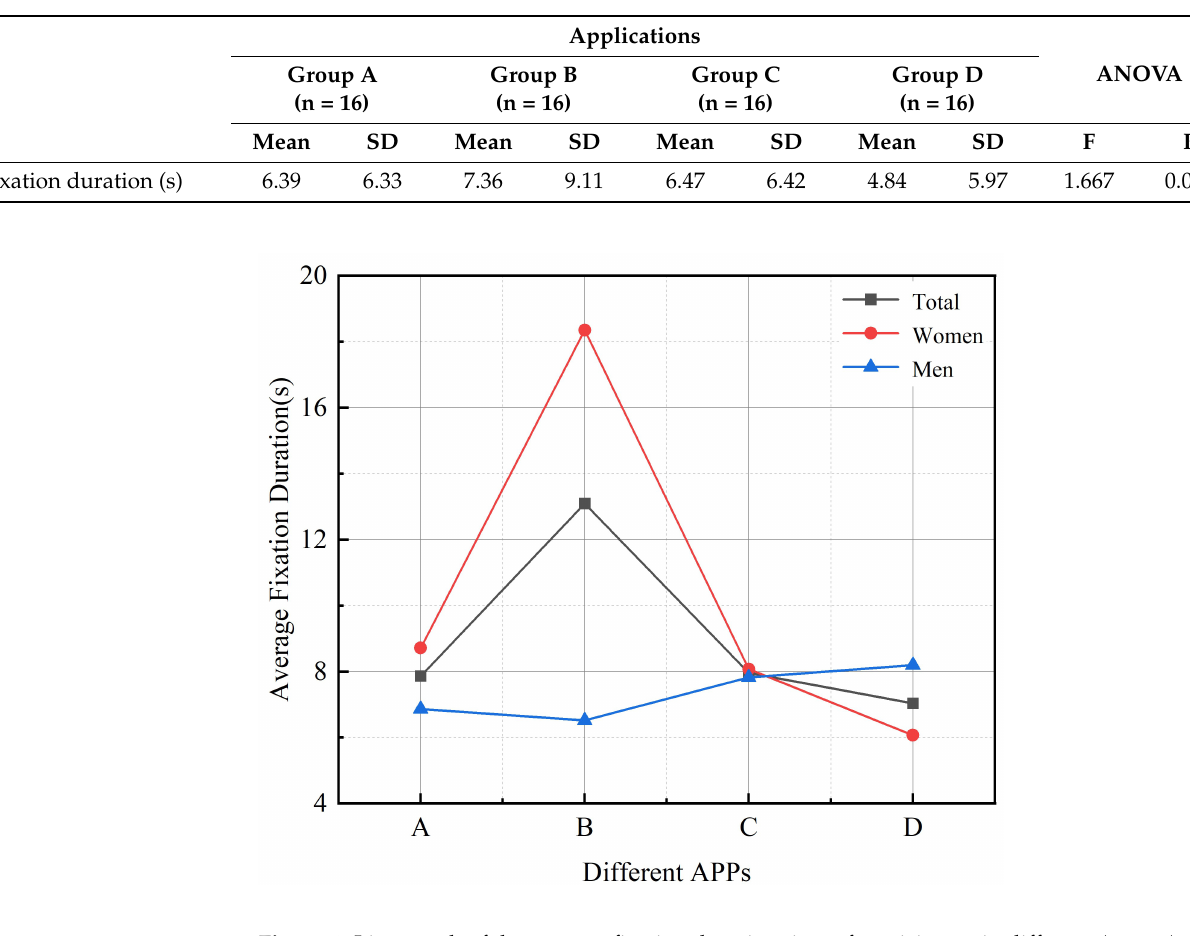
Figure 4. Line graph of the average fixation duration time of participants in different Apps: A refers to C-life Senior Care APP; B refers to Senior Living APP; C refers to Senior Care Manager APP; D refers to Smart Aging